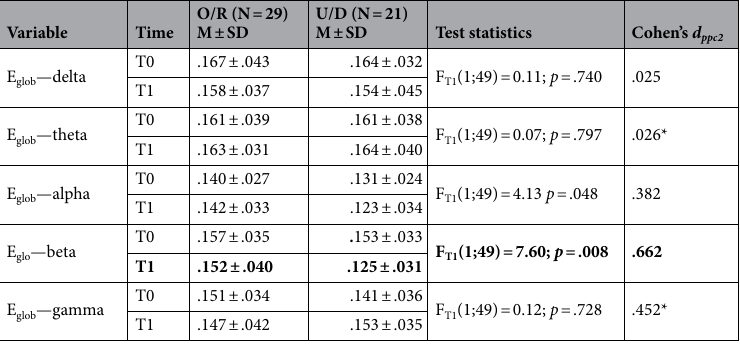
Table 2. ANCOVAs results for global efficiency (E glob ). Mean and standard deviation values for T1 are not adjusted for covariates (i.e., gender, age, and baseline EEG brain network metrics). Significant tests are reported in bold. M mean, SD standard deviation, E glob global efficiency, O/R organized/resolved group, U/D unresolved/ disorganized group, T0 pre Adult Attachment Interview, T1 post Adult Attachment Interview. *Absolute value.